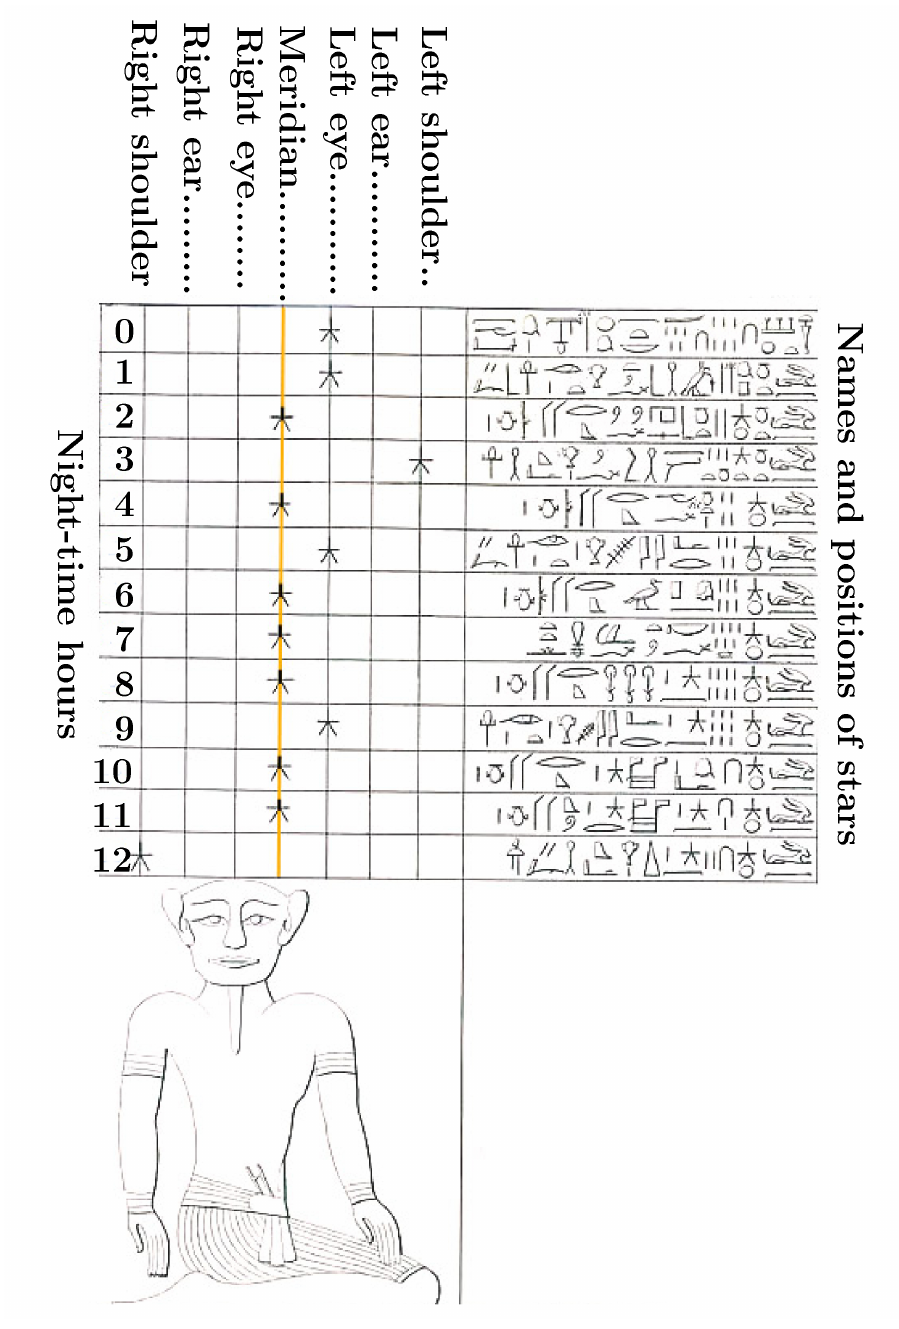
Figure 5. Hour-watcher with a star chart from the tomb of Ramesses VI, 12th century BC. “Meridian” is “opposite the heart” men- tioned in Sect. 4.1. Reprinted under a CC BY license @eng.wikipedia.org.